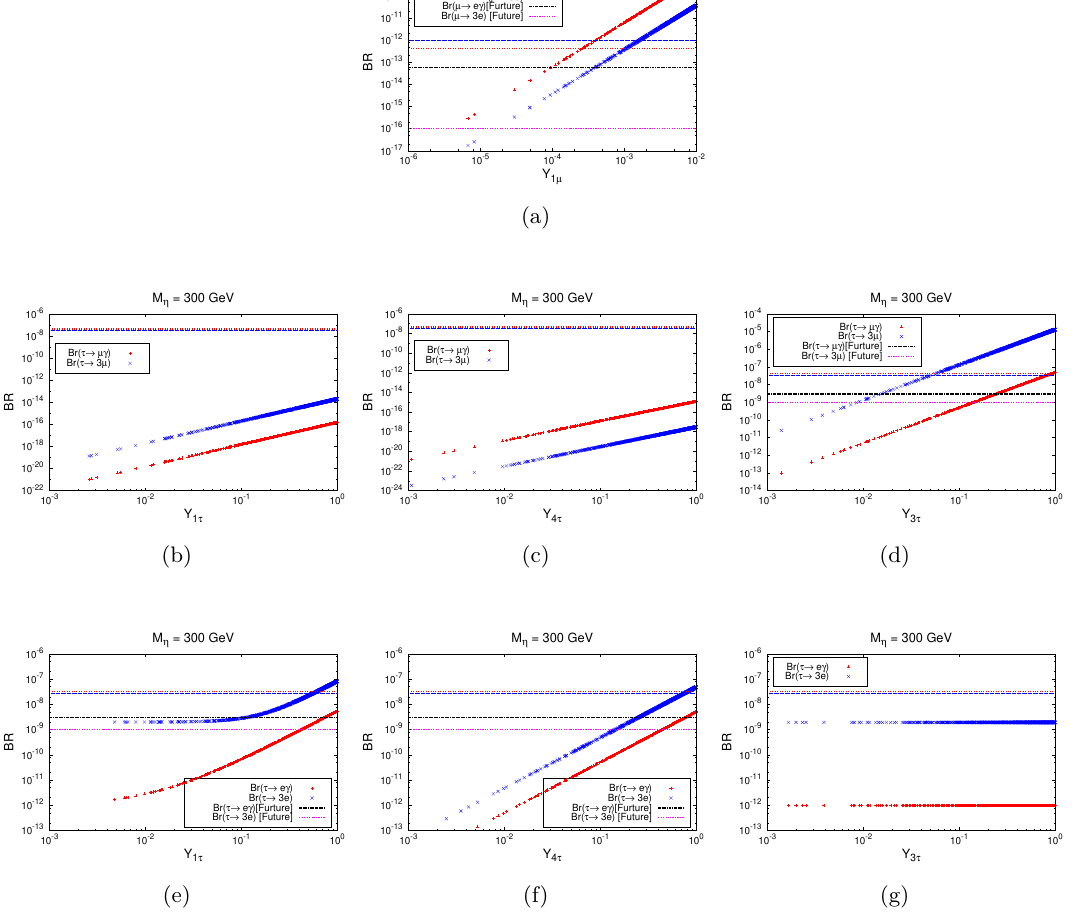
Figure 9 . Variation of Br( ‘ α → ‘ β γ ) (Red) and Br( ‘ α → 3 ‘ β ) (Blue) as a function of Y i‘ [ i = 1 , 3 , 4 ]. Input parameters are set as M = 300 GeV, M = 130 GeV, M = 800 GeV, M = 190 GeV and η S χ 1 L 2 = 120 GeV. In the µ -sector, i.e., for plot (a) the e and µ -specific couplings are fixed at those M χ 0 values which are mentioned in the text. In the τ -sector, we choose for the plot (b) Y = Y = 0 , 4 τ 3 τ (c) Y = Y = 0 , (d) Y = 0 & Y = 0 . 01 , (e) Y = 0 . 01 & Y = 0 , (f) Y = Y = 0 and (g) 1 τ 3 τ 1 τ 4 τ 4 τ 3 τ 1 τ 3 τ Y 1 τ = 0 & Y 4 τ = 0 . 01 . In the plots (a), (d), (e), (f) the projected future bounds corresponding to Br ( ‘ ) and Br ( ‘ 3 ‘ ) have been marked with the black and magenta horizontal α → ‘ β γ α → β lines